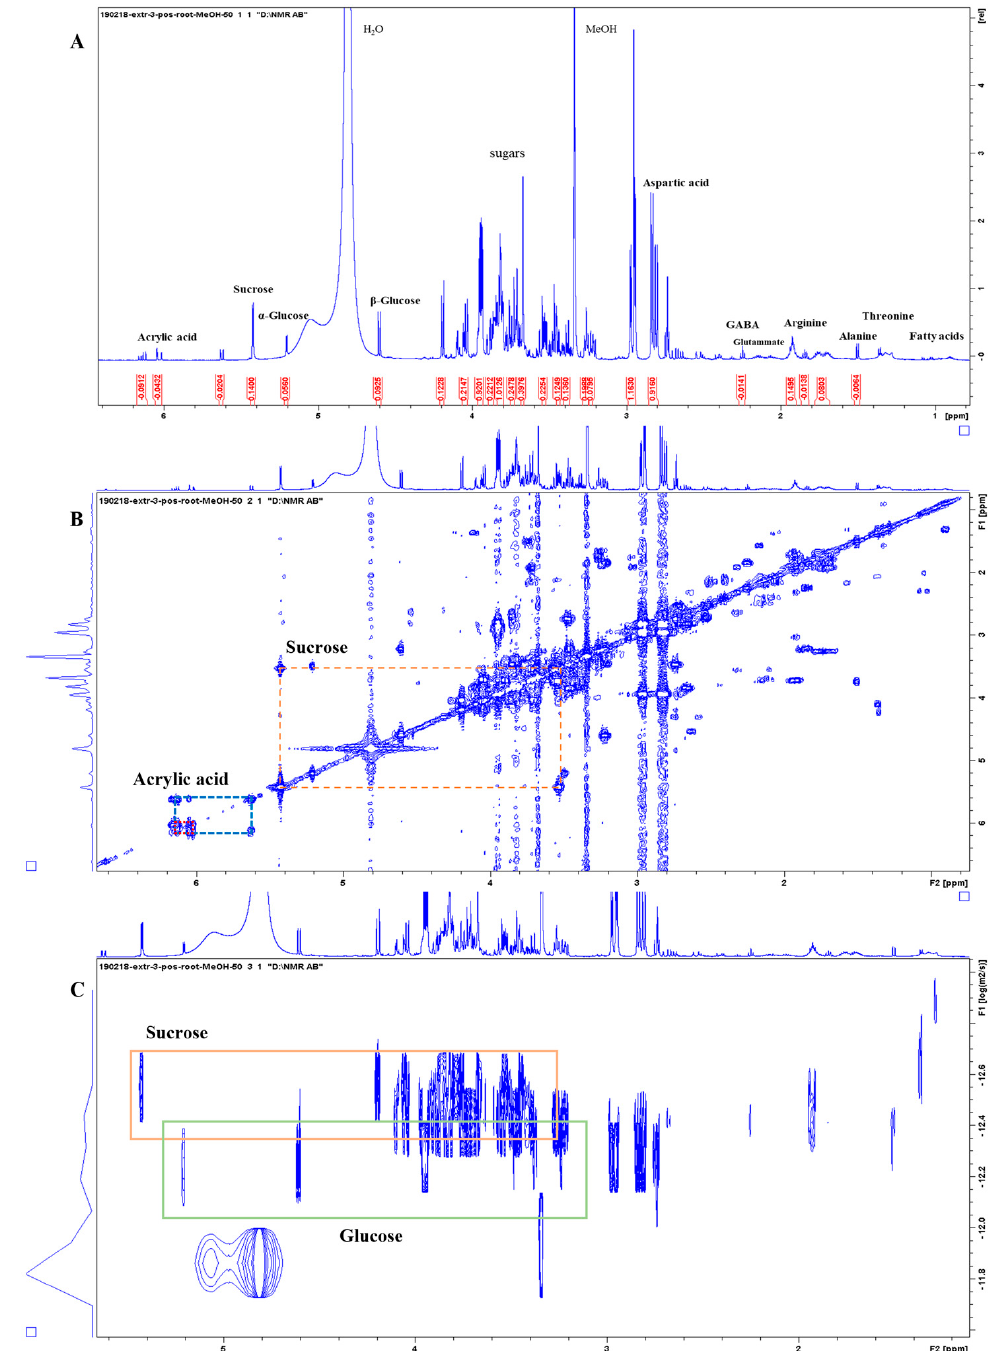
Figure 3. NMR spectra of Posidonia oceanica root extract (CH 3 OH 50% extraction). ( A ) The 1D 1 H- NMR spectrum with a selection of metabolites highlighted; the aromatic regions are not shown here for clarity reasons and full spectra are provided in the Supplementary Materials. ( B ) The 2D 1 H- 1 H-COSY NMR spectrum with representative off-diagonal cross peaks highlighted for sucrose and acrylic acid. ( C ) The 2D 1 H- 1 H-DOSY NMR spectrum with the orange and green boxes highlighting the sucrose and glucose signals, respectively. The vertical axis in the pseudo-2D plot represents the diffusion coefficient of the molecules generating the signals; the monomeric glucose clearly has a much higher diffusion coefficient (i.e., is faster, smaller) than the dimeric sugar sucrose. Considering the samples of Ascophyllum nodosum, compounds identified in the al- coholic extract (Extract 4) comprised mannitol, α and β -Gluc (low concentration), the amino acids Glu, Ala, and Thr, fatty acids including oleic (C18:1 Δ 9) and linoleic acid (C18: 2 Δ 9,12), as well as phlorotannins (Figure 4). Mannitol is an important osmoprotect- ant as it gives the seaweed greater tolerability to abiotic stresses such as increased salinity [39]. It also acts as a chelating agent [40]. Phlorotannins are polymers of phloroglucinol,